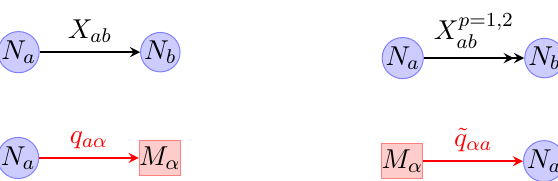
Figure 5. The various (cid:12)elds appearing in this work and their